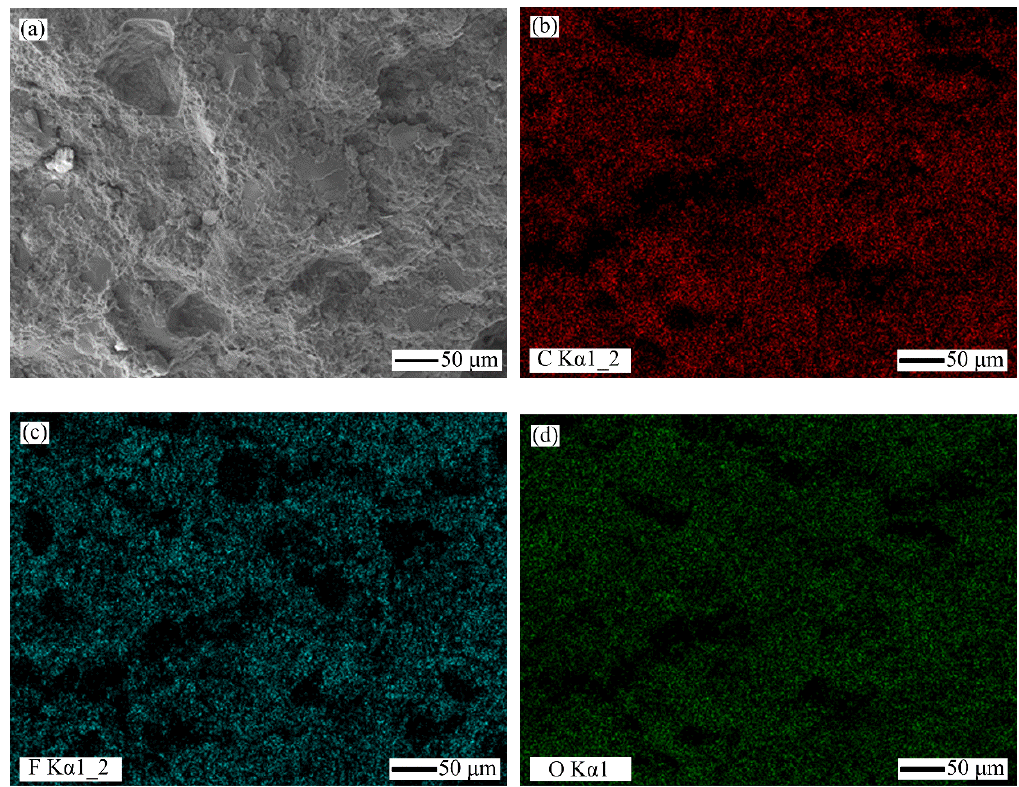
Figure 2. The section’s scanning electron microscopy (SEM) image and energy dispersive X-ray spectroscopy (EDS) mapping of the characteristic elements for 25 wt % PTFE filled PMMA based composite (P/L is 1.22): ( a ) SEM; ( b ) C element; ( c ) F element; and ( d ) O element.